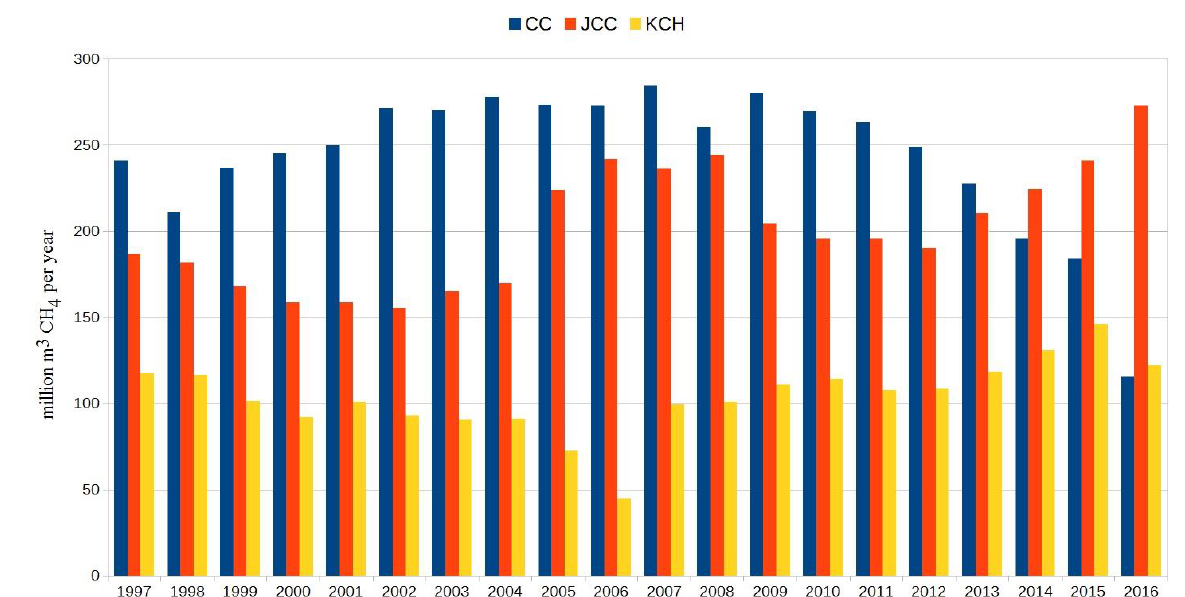
Fig. 10. Ventilation air methane inform the coal